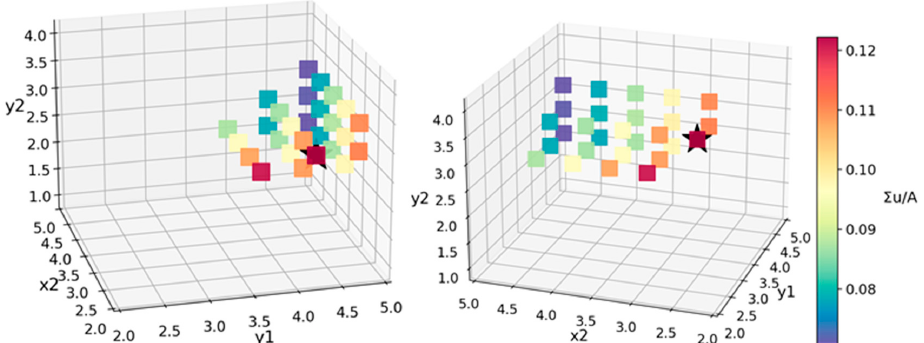
Figure 16. The three-dimensional scatter diagram of array power density (truncation ratio is 0.8). The missing scatters represent that the inflow velocity under this distance parameters is less than the truncation ratio. The left and right pictures are two different side views of the scatter. The three axes are the three distance parameters ( y 1, x 2, y 2). The color bar represents the array power density. The black star represents the maximum array power density (Its coordinates are y 1 = 4.5, x 2 = 3, y 2 =